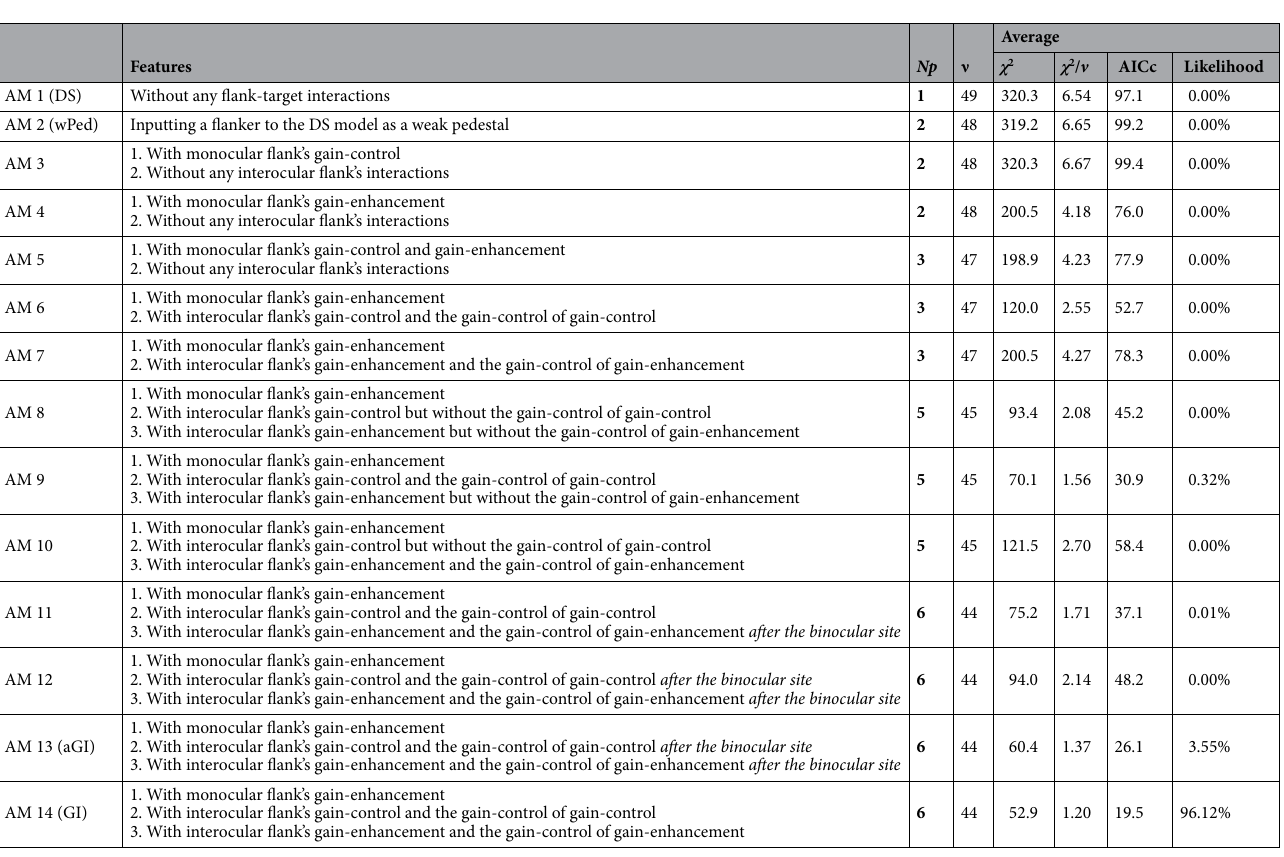
Table 2. Model comparison. Np the number of parameters, ν degrees of